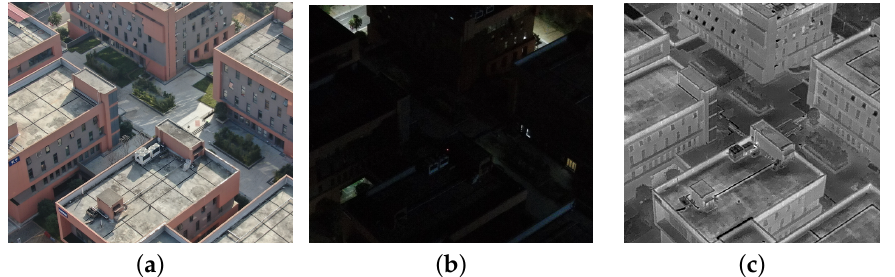
Figure 1. A sample of these two types of images. Compared to visible light photos at night, thermal images are imaged through temperature differences and can capture sharper edges and textures at night. ( a ) Visible daytime, ( b ) Visible night-time, ( c ) Thermal